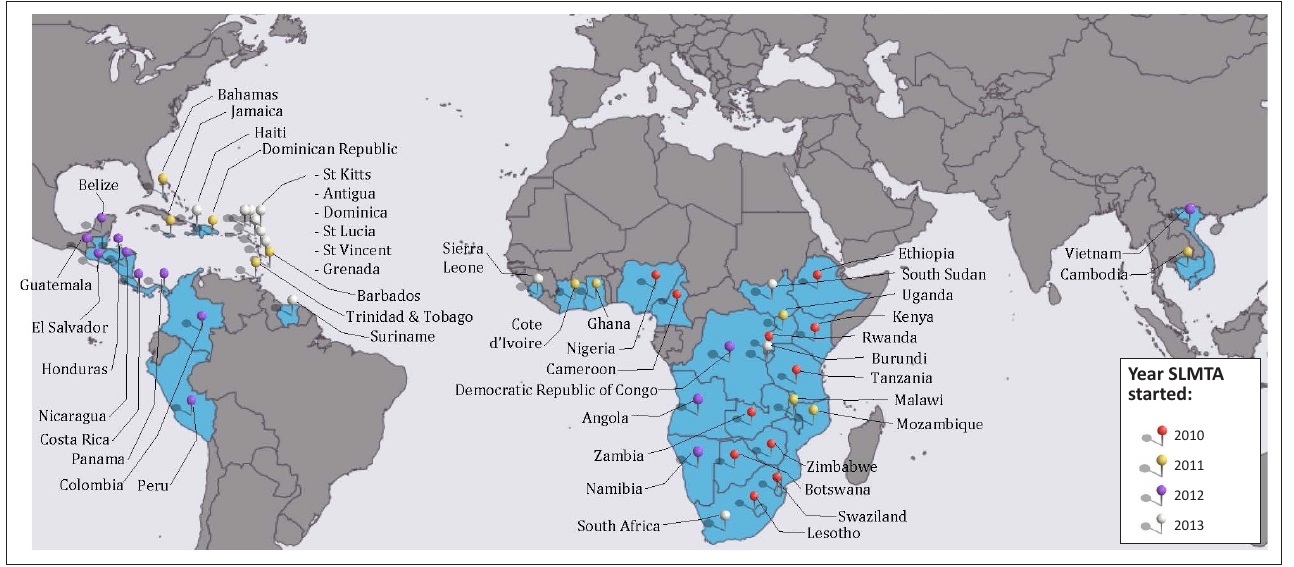
FIGURE 1: Global reach of SLMTA by year of implementation, 2010−2013 ( n = 47